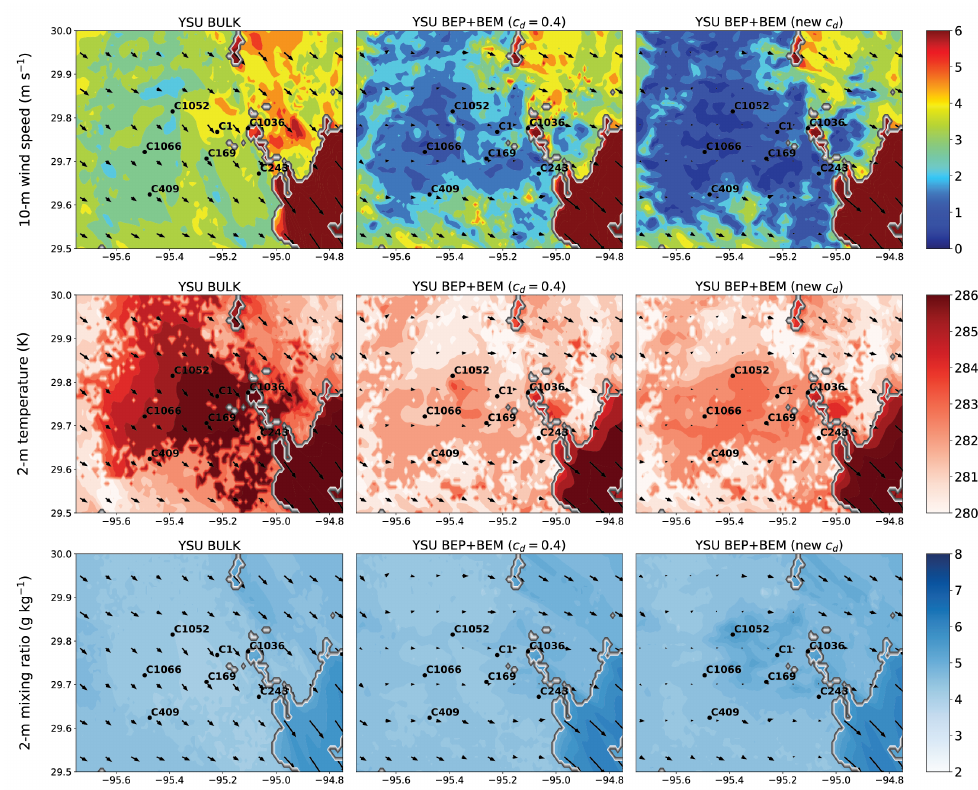
Figure 6. WRF model’s simulated near-surface fields at 12:00 a.m. UTC 23 January (7:00 a.m. LST). Vectors are shown every 10 model grid